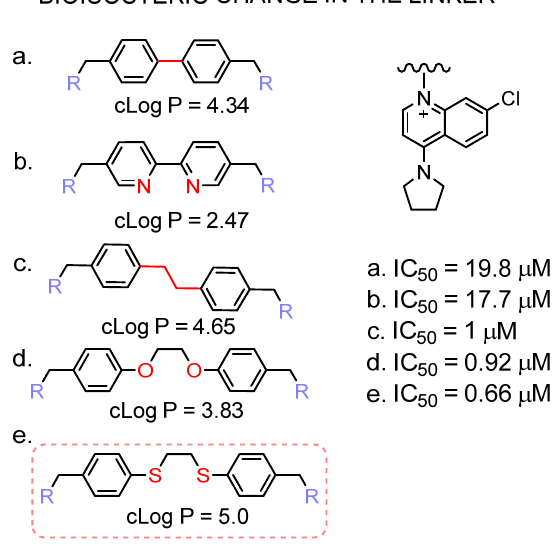
Figure 6. Effect of the linker bioisosteric change in the inhibitory activity towards the ChoK α 1. The IC 50 values of compounds ( a – d ) are taken from [21,41,42], ( e ) corresponds to PL48.